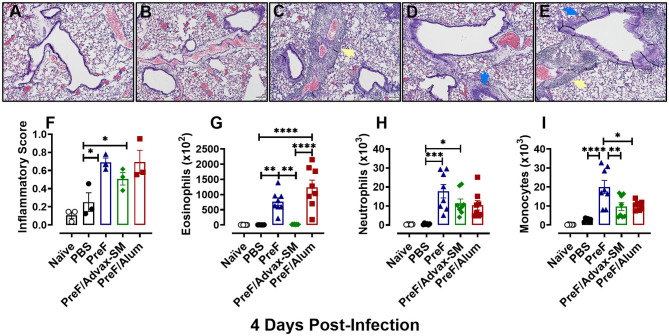
PreF and PreF/Alum immunization elicited enhanced pulmonary inflammation characterized by robust airway eosinophil recruitment. Naive mice were immunized and challenged with RSV as described in Figure 1. At 4 dpi, left lungs were formalin filled, paraffin embedded and sectioned for staining with H&E. Each panel represents an individual mouse from the indicated group (Scale bar 100 μm) (A–E). Two blinded, independent pathologists scored all slides as described in the methods. Scores between the two investigators were averaged and data is represented as mean ± SEM (n = 3 mice) (F). At 4 dpi, BAL was collected and eosinophils (G), neutrophils (H), and monocytes (I) were identified via flow cytometry. Data are represented as mean ± SEM (n = 6–8 mice per group);*p < 0.05, **p < 0.01, ***p < 0.001, and ****p < 0.0001. Yellow arrows highlight perivascular inflammation and blue arrows highlight peribronchial inflammation.